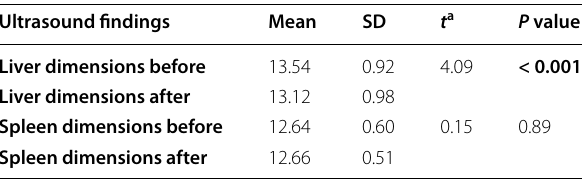
a Paired samples t test